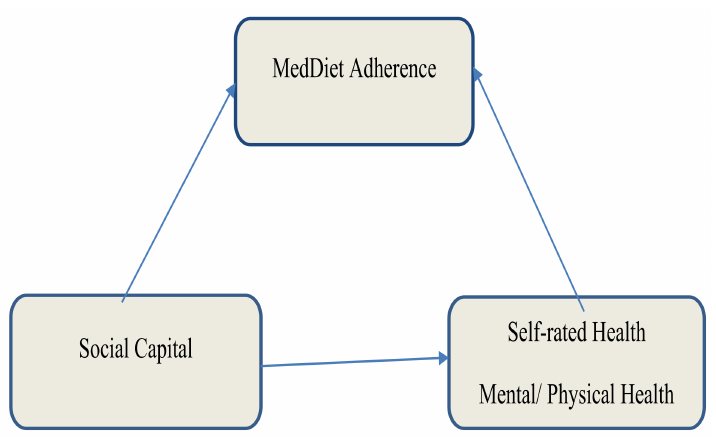
Figure 1. Hypothesised model: research hypothesis of the interactions between Social Capital and Self Rated Health on Mediterranean Diet (MedDiet)